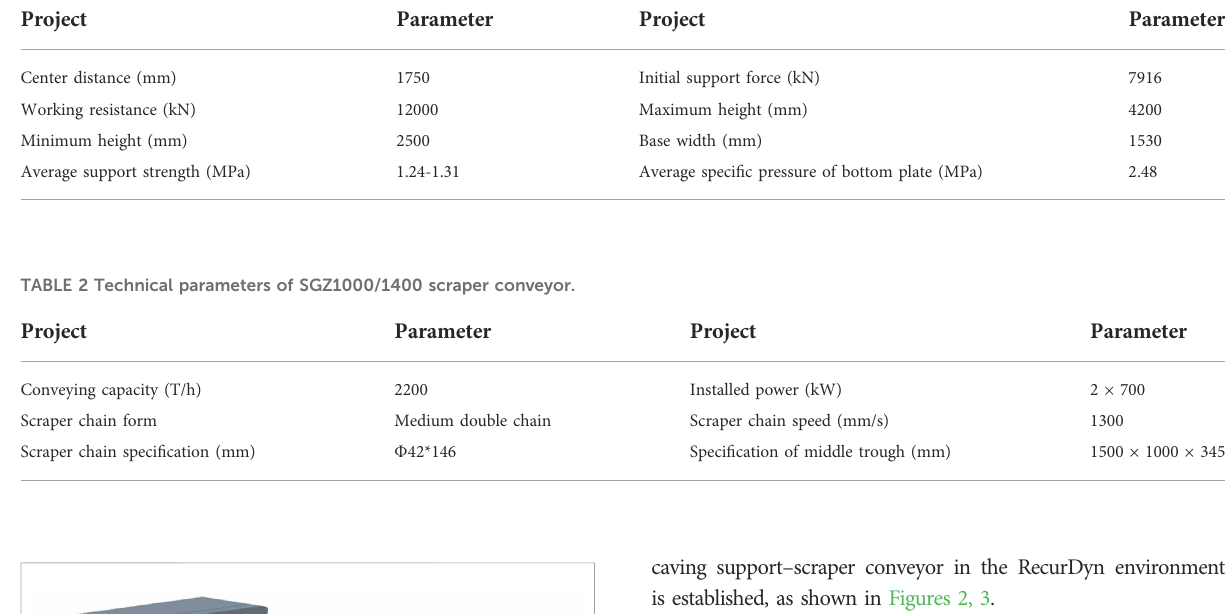
TABLE 1 Main technical parameters of ZFY12000/25/42D type support.